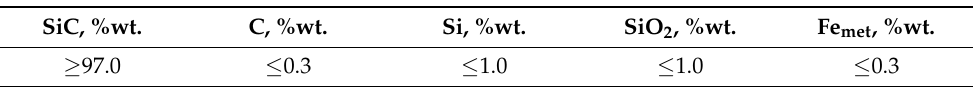
Table 3. Chemical composition of β -SiC silicon carbide used in the tests according to the manufac- turer’s data [15]. SiC, %wt. C,